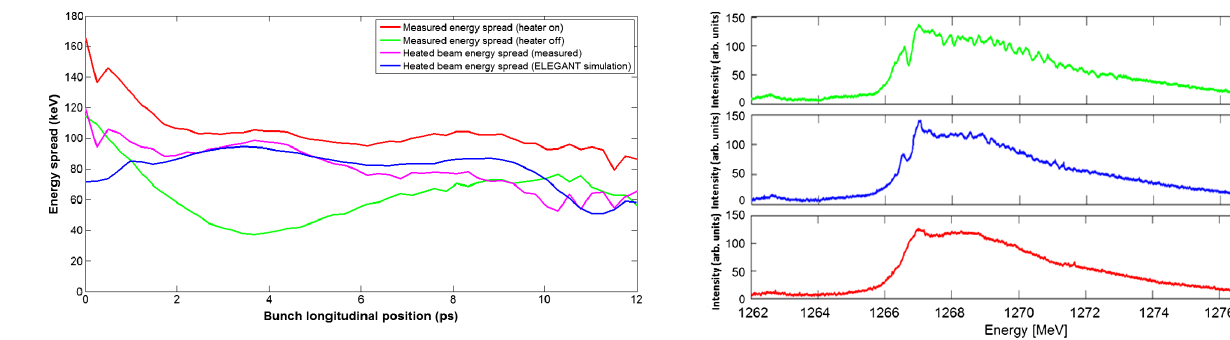
FIG. 8. 500 pC, 350 A peak current electron beam energy profile determined at the diagnostic beam dump (DBD) spec- trometer, at the end of the linac, for three levels of LH beam heating: no heating (top), 5 keV rms (middle), 15 keV rms (bottom). These heating values are calculated from the measured values of the laser parameters according to Eq. (3).